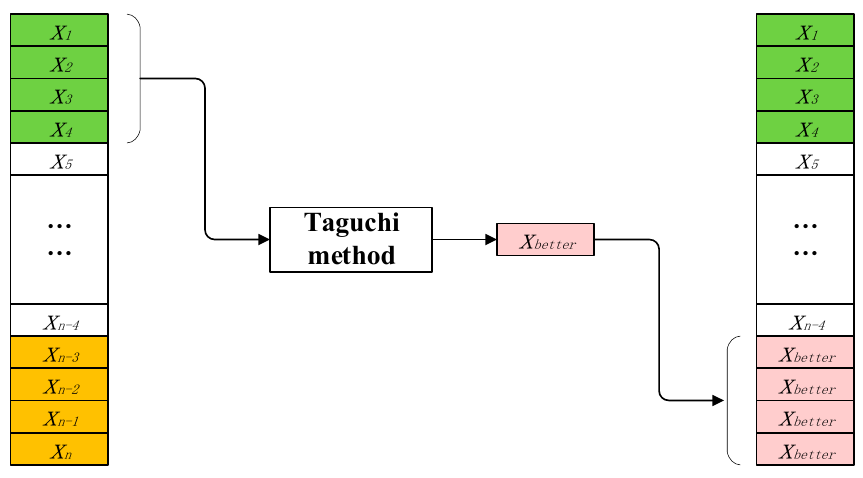
Figure 2. The new communication strategy 1.